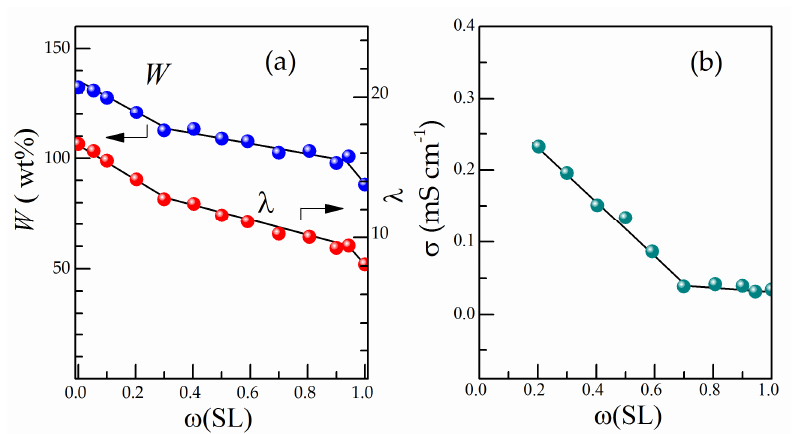
Figure 3. Weight uptake ( W ) and molar uptake (λ) ( a ) and conductivity of swollen Li-Nafion membrane at 25 °C ( b ) as a function of ω(SL) (mixing temperature of 40 °C)